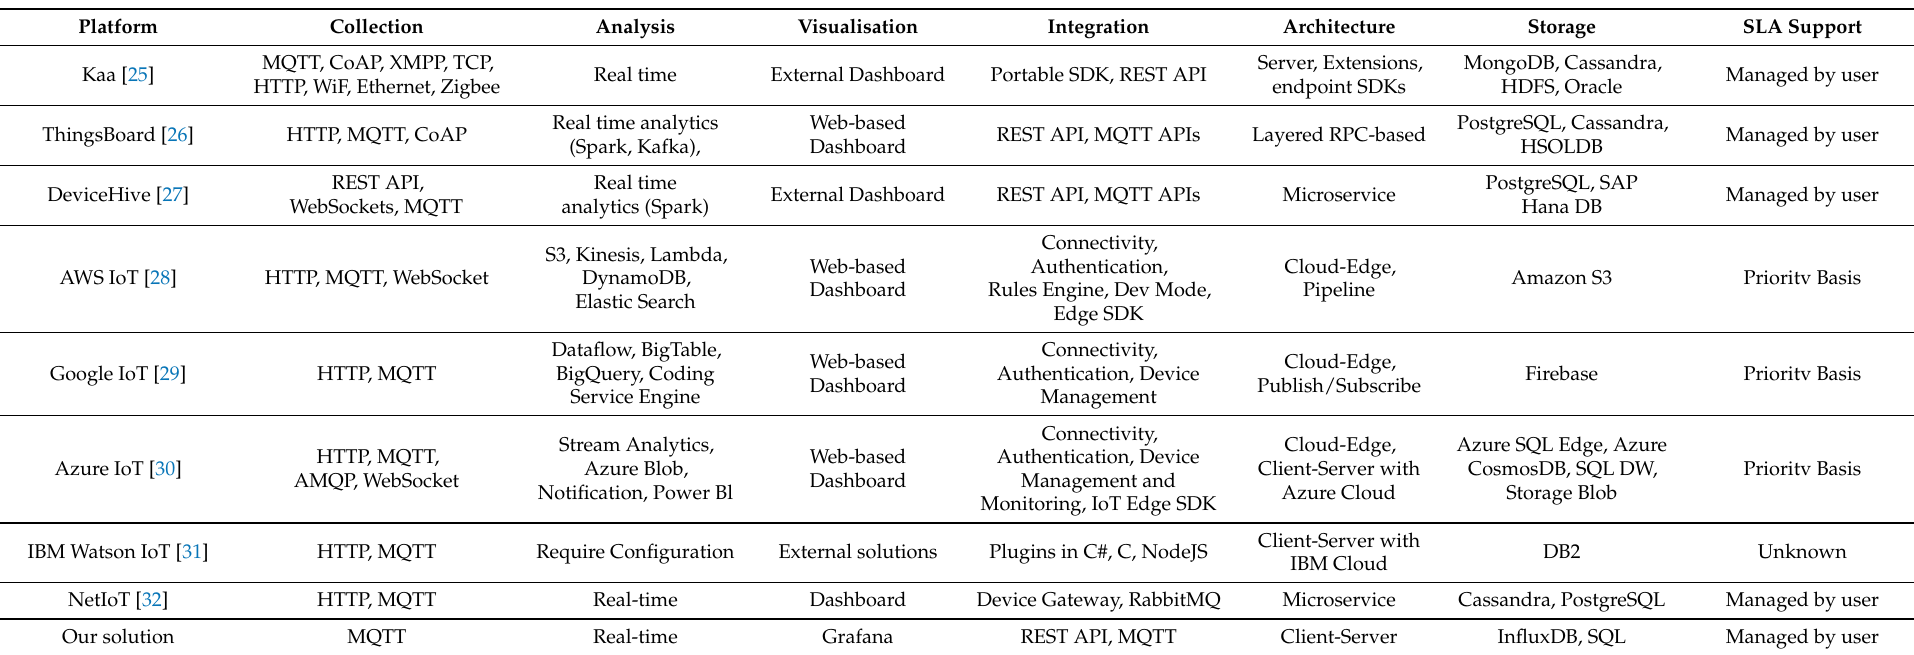
Table 1. Comparison of existing IoT data collecting